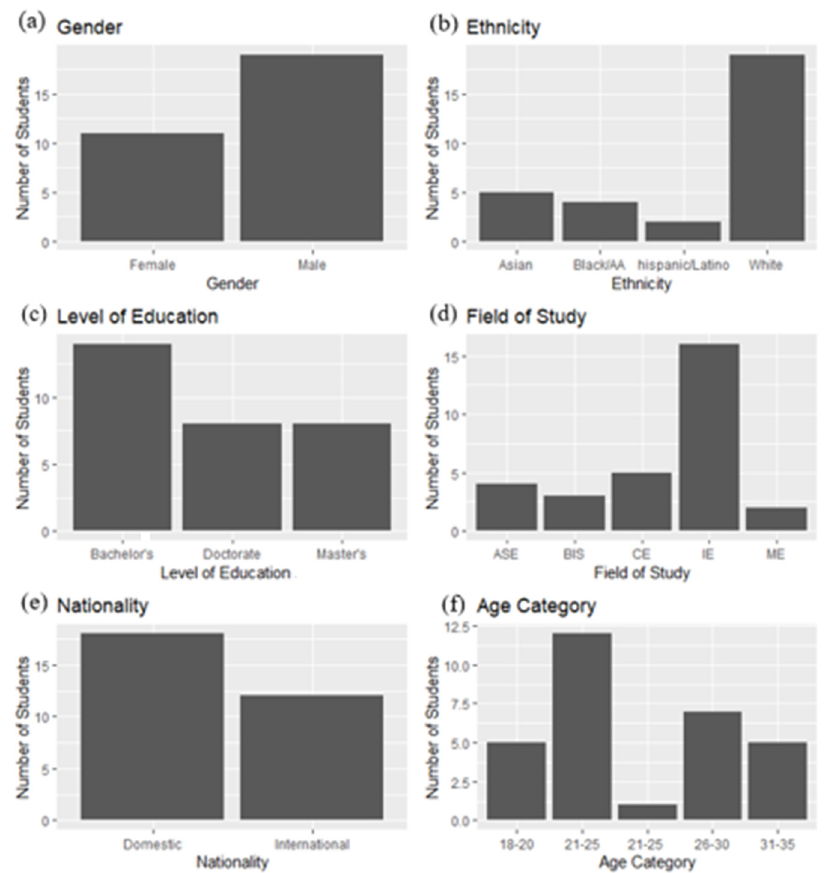
Figure 14. Demographics information ( a ) Participants’ gender distribution. ( b ) Participants’ ethnicity distribution. ( c ) Participants’ current education level. ( d ) Participants’ field of study distribution. ( e ) Participants’ nationality distribution. ( f ) Participants’ age category distribution.